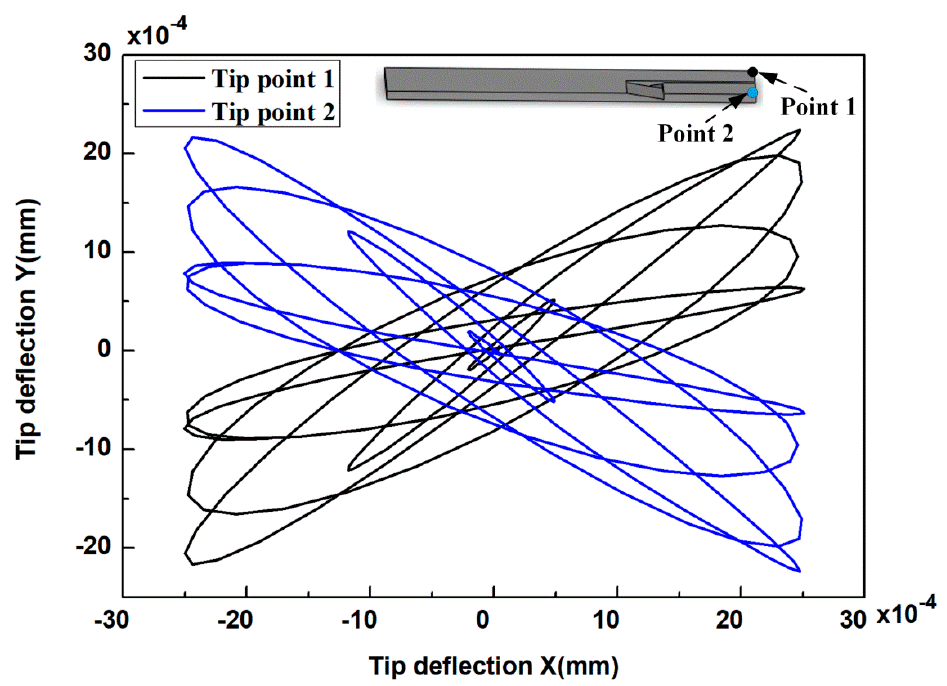
Figure 7. The vibration trajectories of an actuator with a beam tip of 9 mm.